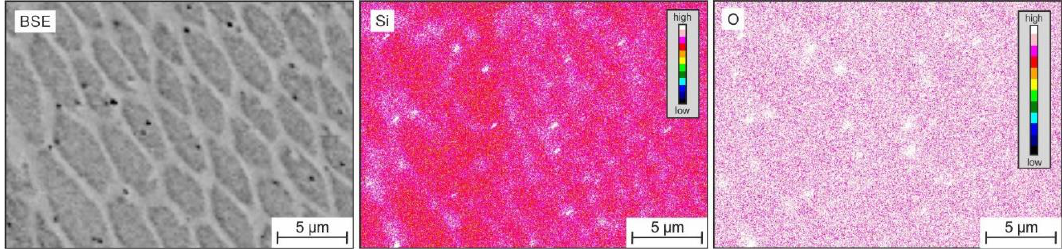
Figure 6. Qualitative energy dispersive X-ray spectrometer (EDS) element mapping shows the cellular segregation substructure developed during LMD processing.